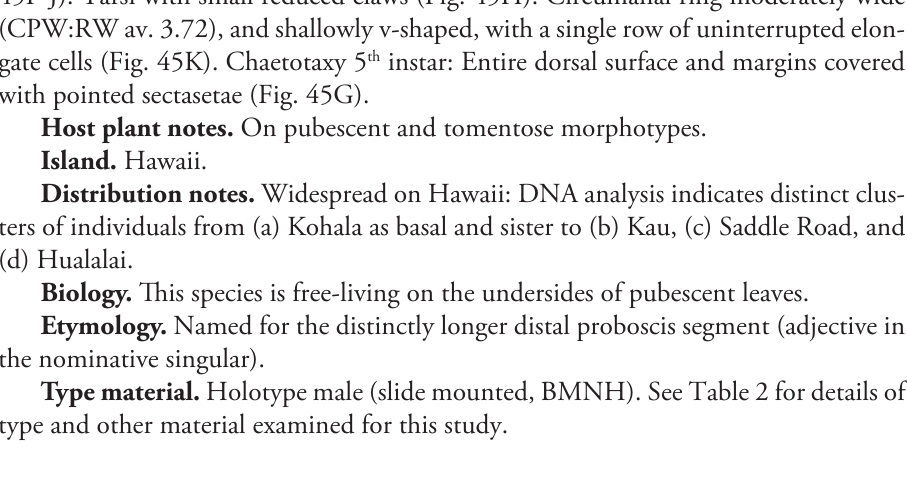
length of the body. Fore wing membrane slightly